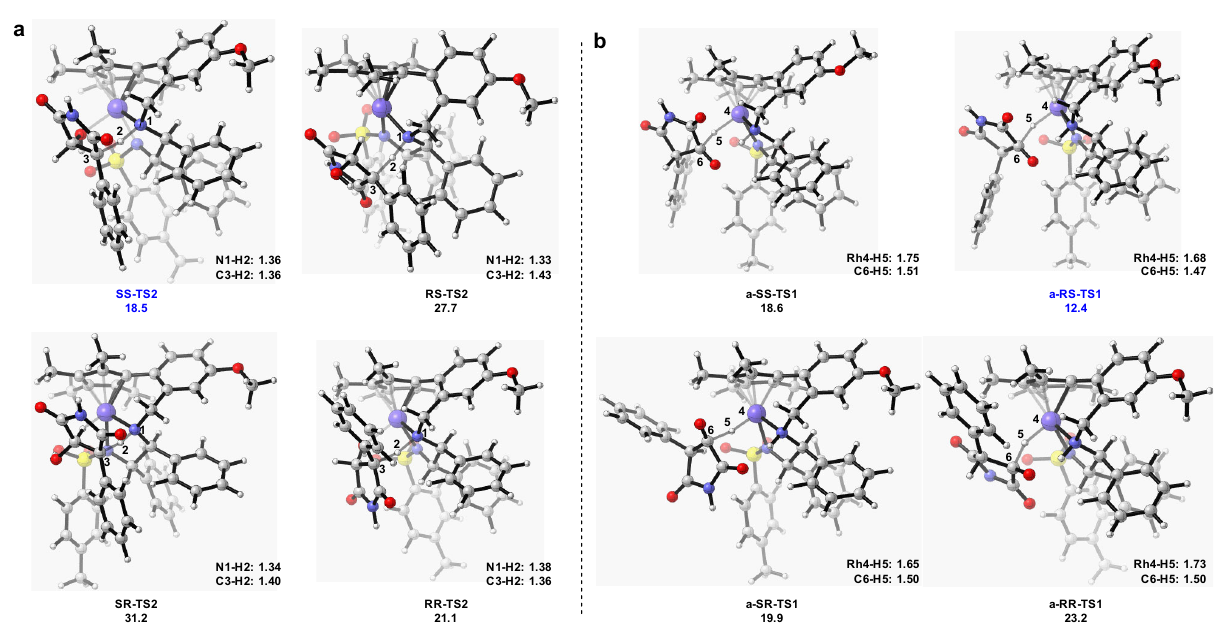
Fig. 6 | Proposal catalytic cycle for ATH of 1g with HCOOH. The C=C reduction pathwaywasdepictedintheleftcatalyticcycleandtheC=Oreductionpathwaywas described in the catalytic cycle on the right. The Gibbs free energy of the